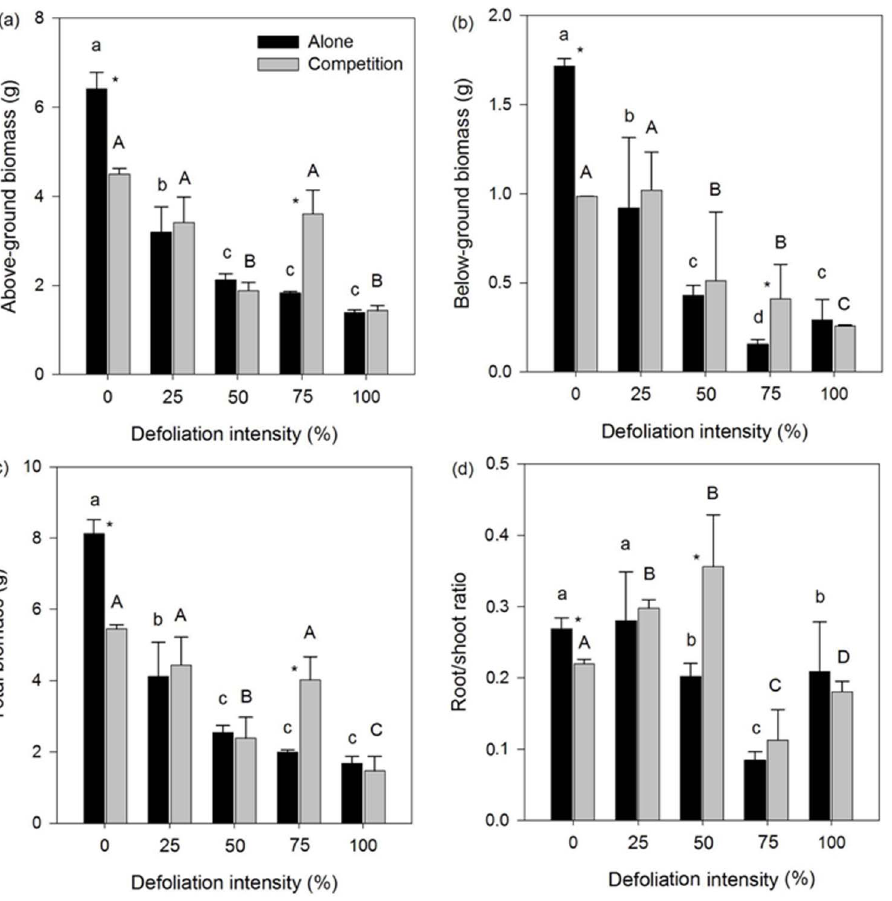
Figure 1. Effect of defoliation and competition on the above-ground (a), below-ground (b), total biomass (c) and root/shoot ratio (d) of invasive Mikaniamicrantha. Values are means 6 standard deviation. The different lowercase and uppercase letters indicate significant differences ( p , 0.05) among the defoliation intensities of invasive Mikania micrantha growing with and without a native competitor, respectively. * indicates a significant difference ( p , 0.05) between the treatments with or without the